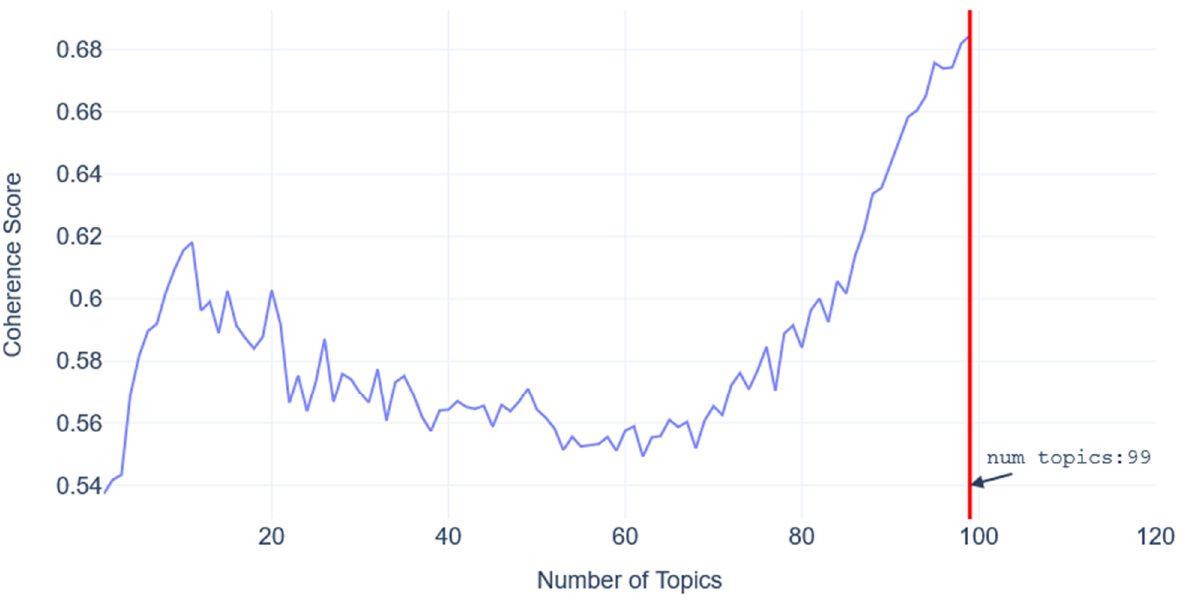
Figure 8. LDA coherence score as a function of the number of topics.